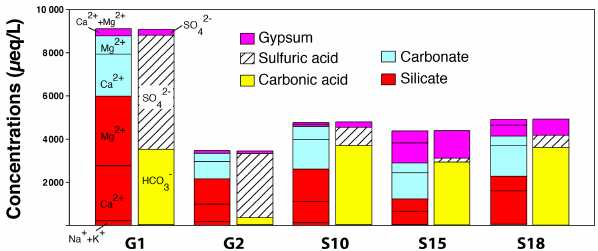
Figure 5. Concentration (in charge equivalents) calculated for ma- jor dissolved species and for each end member from the mixing model presented in the text and in the Supplement (Table S2). Sil- icates contribute Na + K + Ca + Mg (Na + K not indicated), car- bonates contribute Ca + Mg and gypsum dissolution contributes Ca + Mg (not distinguished). Note that the hydrogenocarbonate ion ultimately originates from respiration in soils. Sulfuric acid is gen- erated by the oxidation of sulfide minerals, a process that occurs preferentially in the fractured zone. Relative contributions of differ- ent end members were obtained by solving a set of mixing equations using a Monte Carlo approach (Sect. 5.1.3). Note that the relative contribution of each rock end member to the Ca 2 + load here refers to that calculated for the Ca “initially” released into solution – that is, before secondary carbonate precipitation